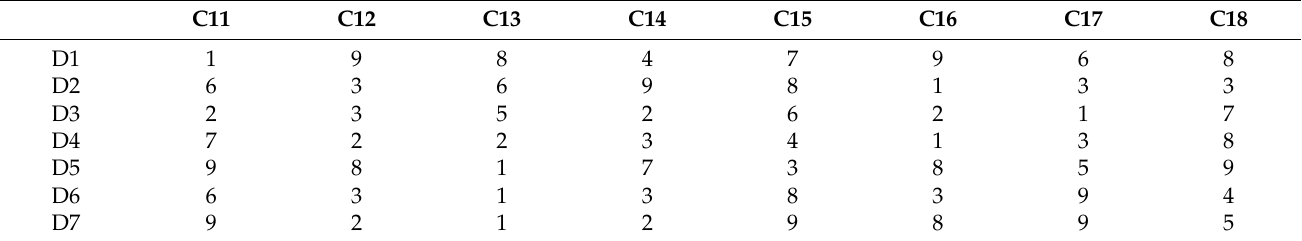
Table 1. Best-to-others comparison between eight criteria in the carrier selection